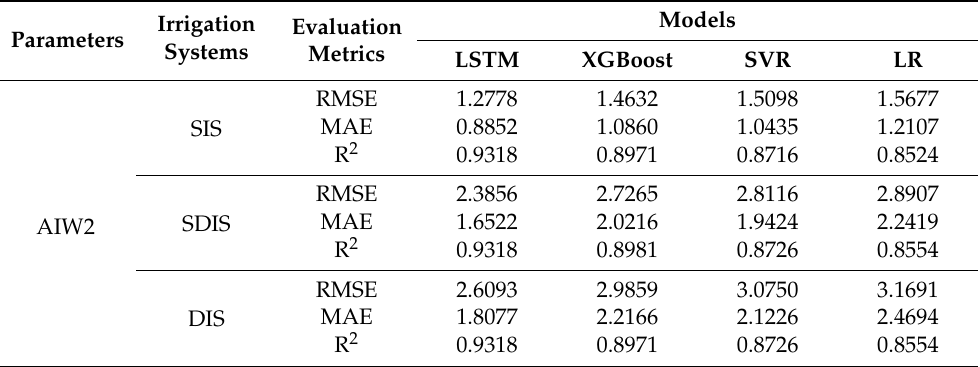
SIS, SDIS, DIS, and BIS refer to subsurface irrigation, subsurface drip irrigation, drip irrigation, and bubbler irrigation systems, respectively. RMSE, MAE, and R 2 refer to the root mean square error, the mean absolute error, and the coefficient of determination, respectively. Table 6. Comparison among evaluation values of three performance metrics for ML models based on the testing dataset for predicting the irrigation water requirements (IWR2) and the electrical energy requirements (EER2) when the target is to achieve the optimum date palm yield using different solar- powered micro irrigation systems based on limited meteorological data, i.e., average temperature, RH, wind speed, solar irradiance, and date palm